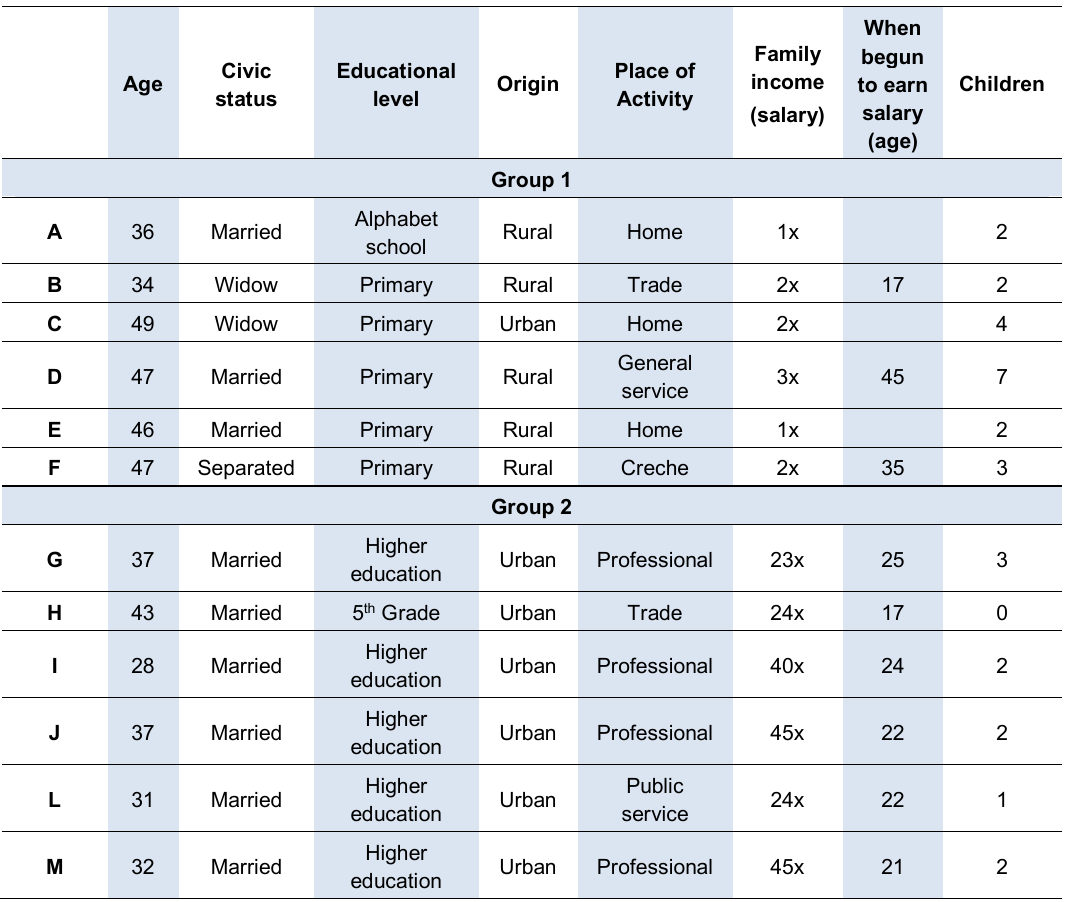
Table 1: Characteristics of